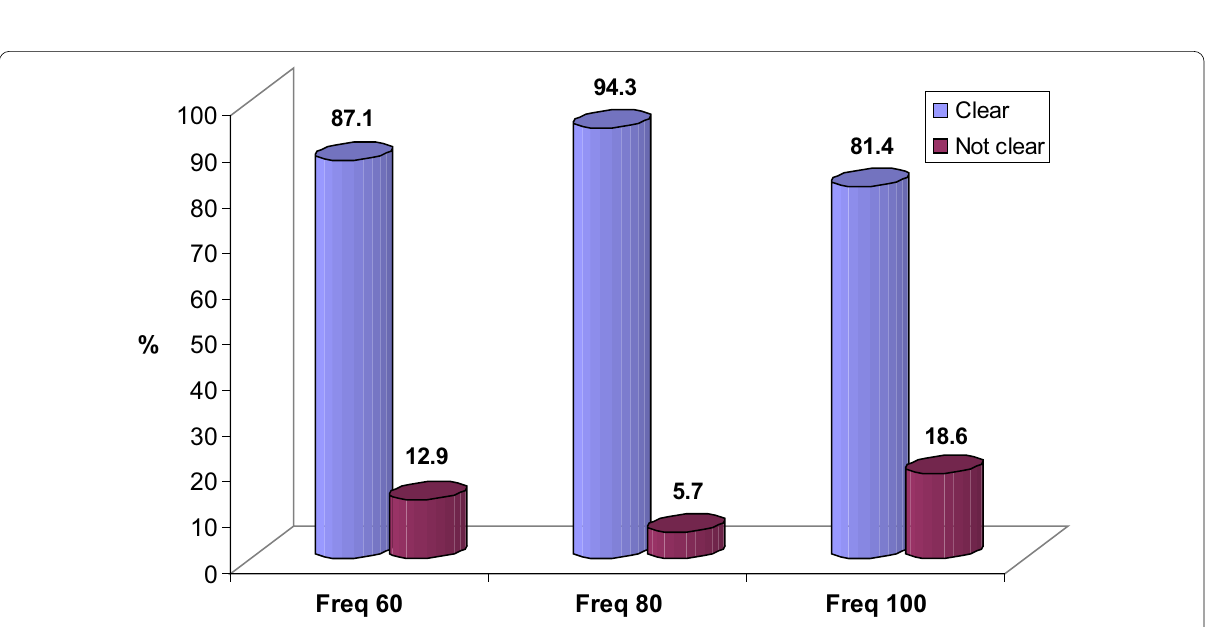
Fig. 2 Stone clearance in each